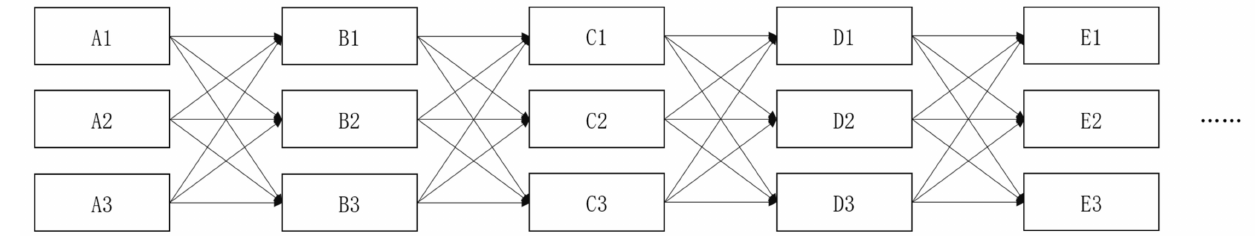
Figure 2. Analysis chart of encoding rule.